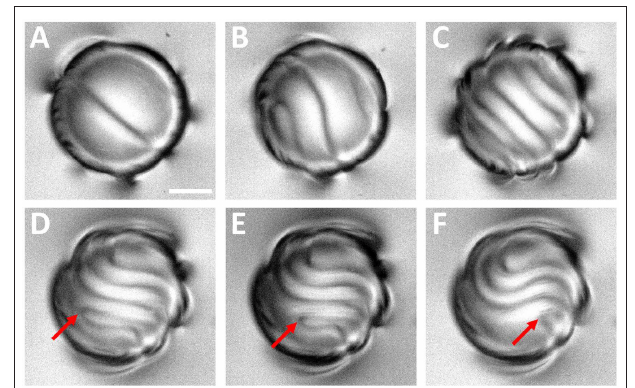
FIGURE 4 | Simulated perception of the Saturn Ring disclination. Different single-mode oscillations are reconstructed at the highest amplitude of deformation for two point-of-view observations, ϕ . Deformation modes are m = 1 (A,B) , m = 2 (C,D) , m = 4 (E,F) . (B,D,F) correspond to points of view rotated 45 ◦ clockwise with respect to (A,C,E) , respectively.